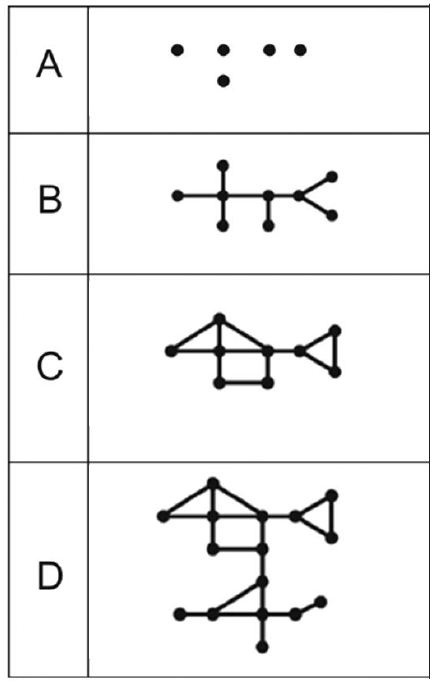
Fig. 3. The shaping stages of a graph structure: A – single null graphs, formation of new nodes, which do not yet create a complete graph, in this case a graph is a set of unstructured nodes (not coupled topographically); B – development of a tree-shaped graph, next to existing parts of a graph new nodes and edges are formed, they expand the structure of the existing connected graph; C – further development of the graph structure, the formation of closed connections (cycles) within the graph structure; D – complex graphs, and even groups of graphs, higher ranks of structures are created through external inter-settlement connections (the structure resembles a stream capture). Source: Zagożdżon 1970, Szmytkie